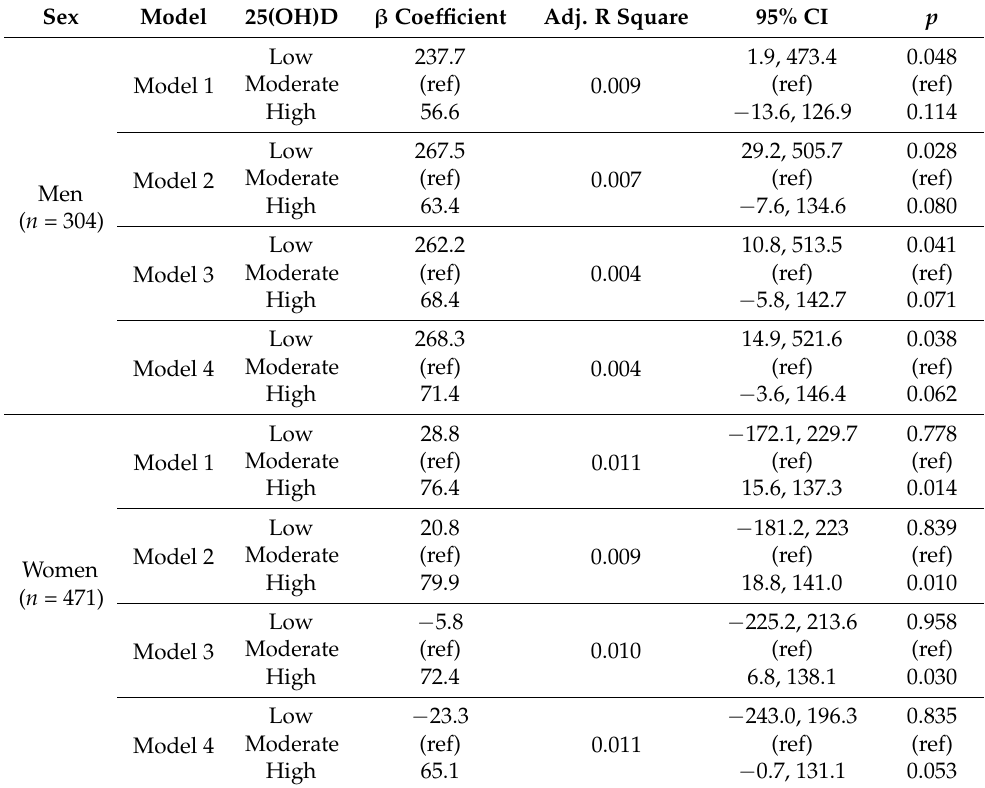
Table 3. Association between 25(OH)D cut-offs and telomere length by sex at